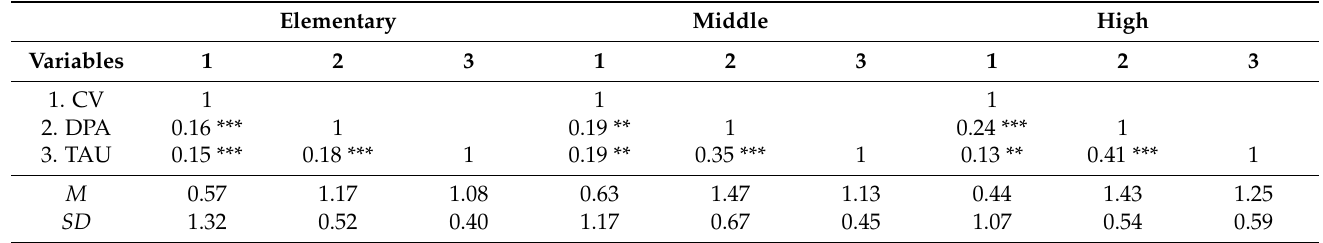
Table 1. Descriptive statistics and correlations among study variables.